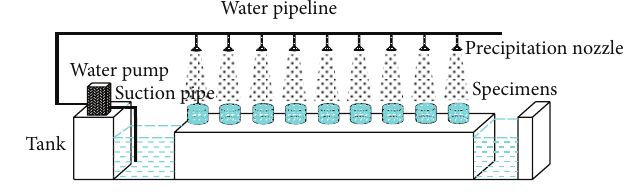
Figure 2: Rainfall simulation